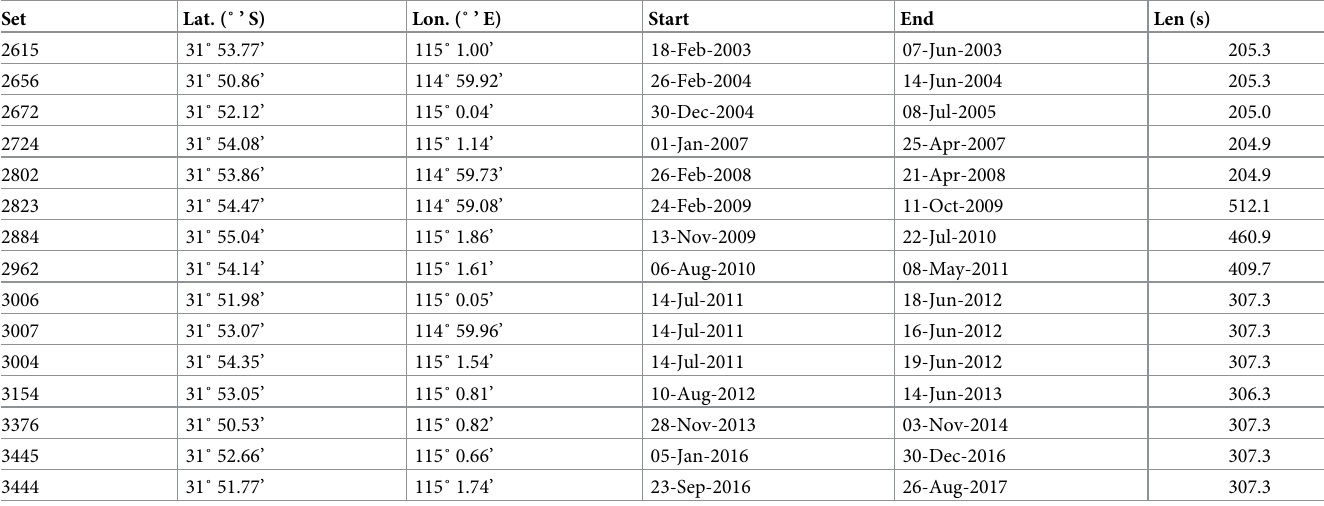
Table 1. Details of sea noise logger primary